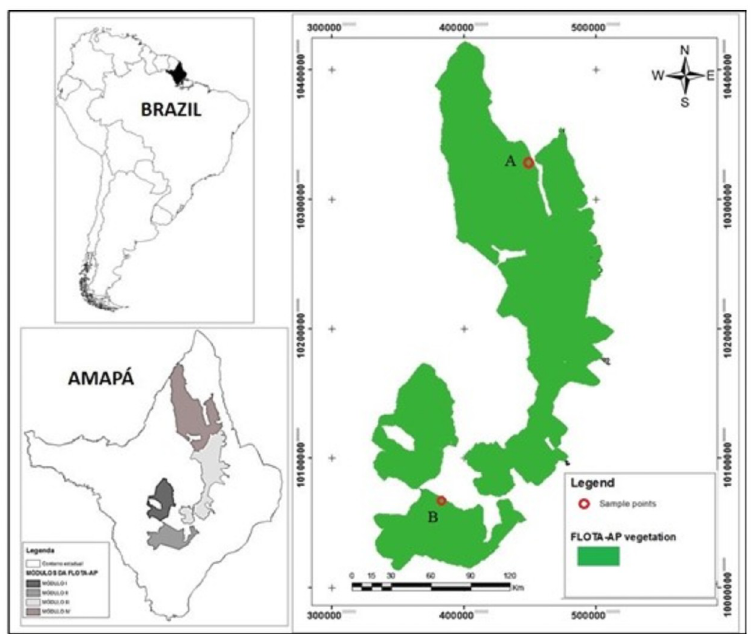
Fig 1. Study locations: Area A located in Calc¸oene and Oiapoque municipalities and area B located in Porto Grande municipality. Figure produced by the main author.